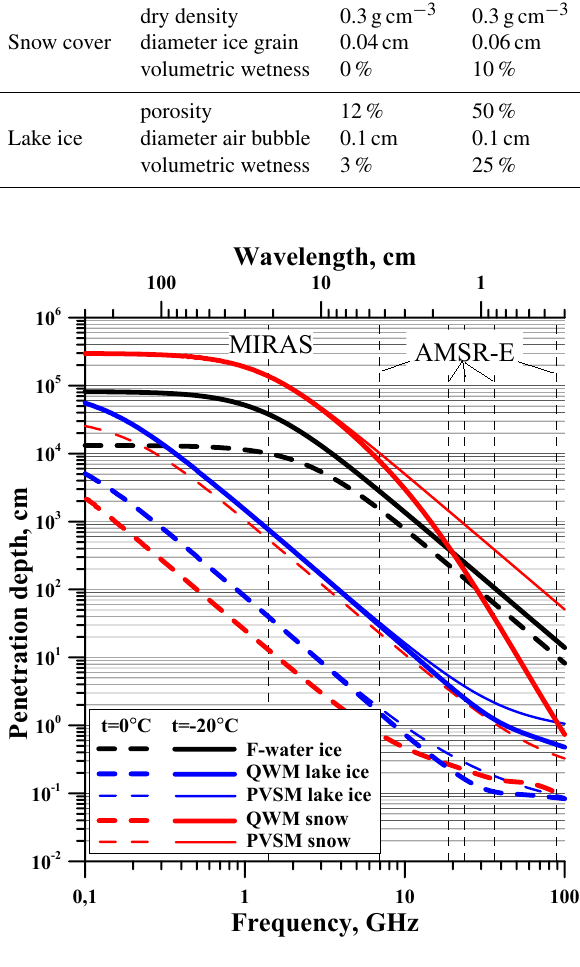
Figure 8. Radiation penetration depth in continuous freshwater ice, snow, and lake ice calculated by the PVSM and QWM models. Lake snow and ice parameters are given in Table 2. AMSR-E and MIRAS frequencies are indicated by vertical dashed